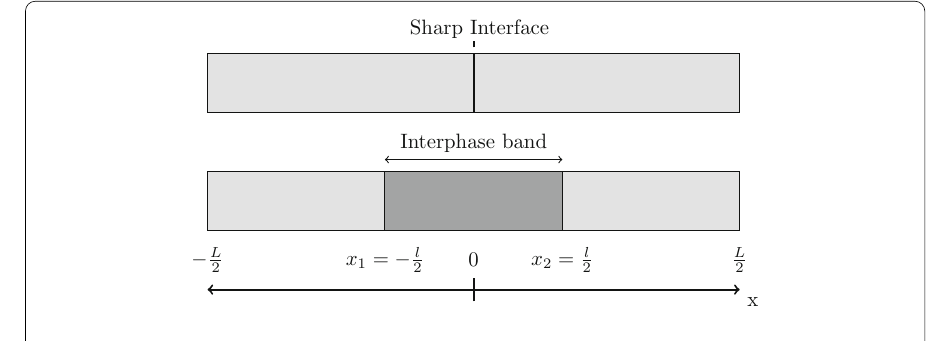
Fig. 2 1D bar with an interphase band (bottom) representation of a central sharp interface